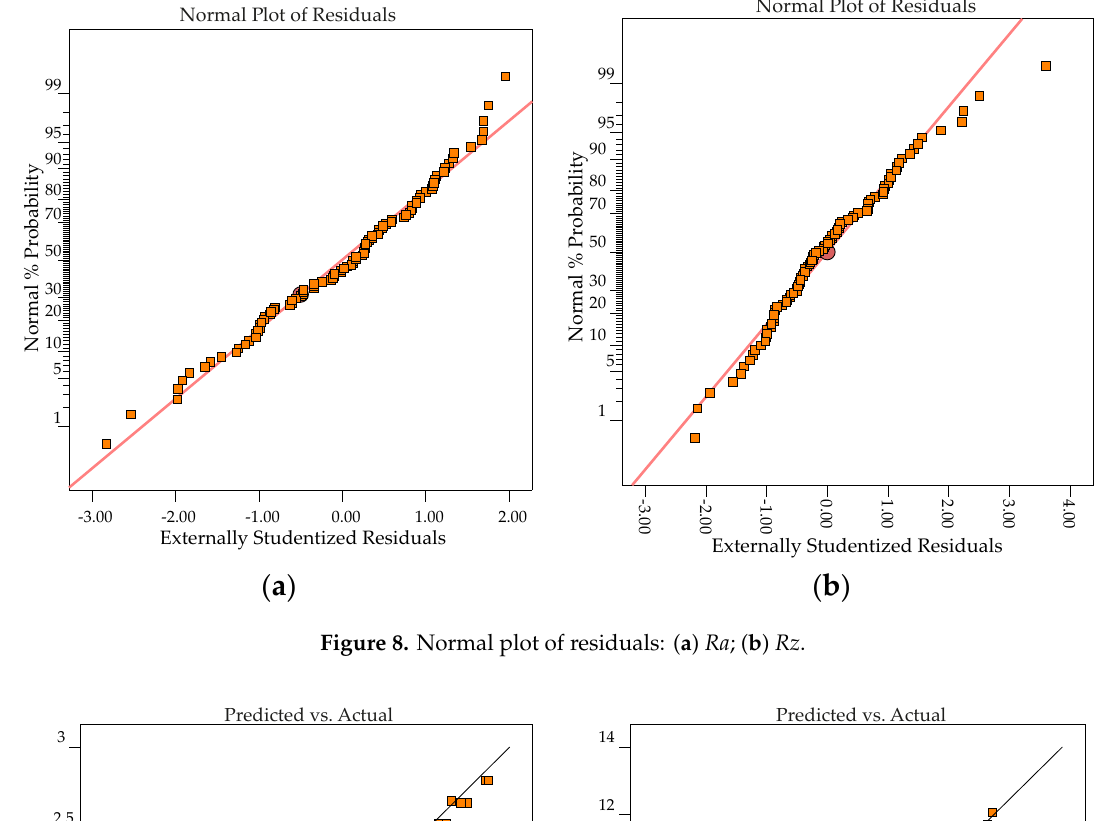
Figure 8. Normal plot of residuals: ( a ) Ra ; ( b ) Rz .